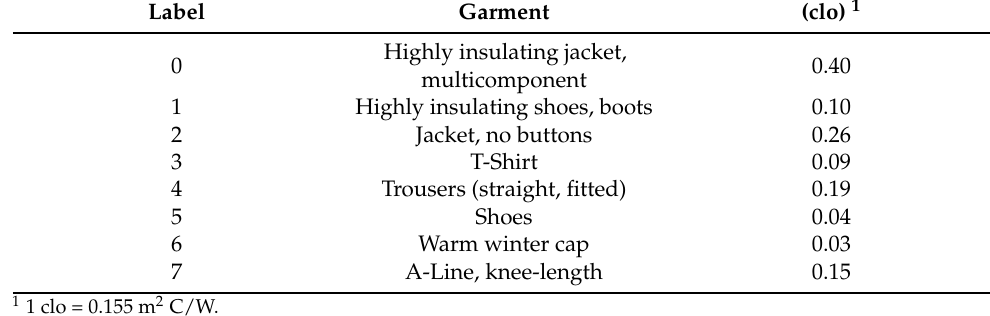
Table 2. Clothing insulation values considered for the classes.